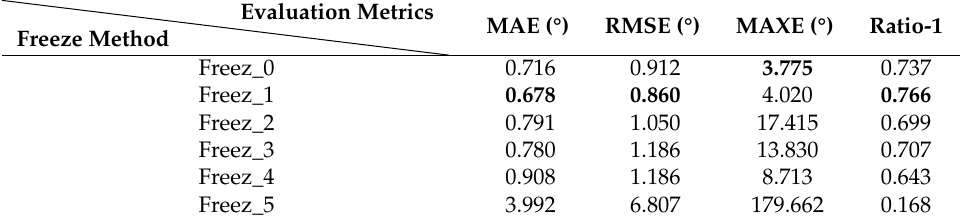
Table 4. Test results of freezing different network layers. Freeze